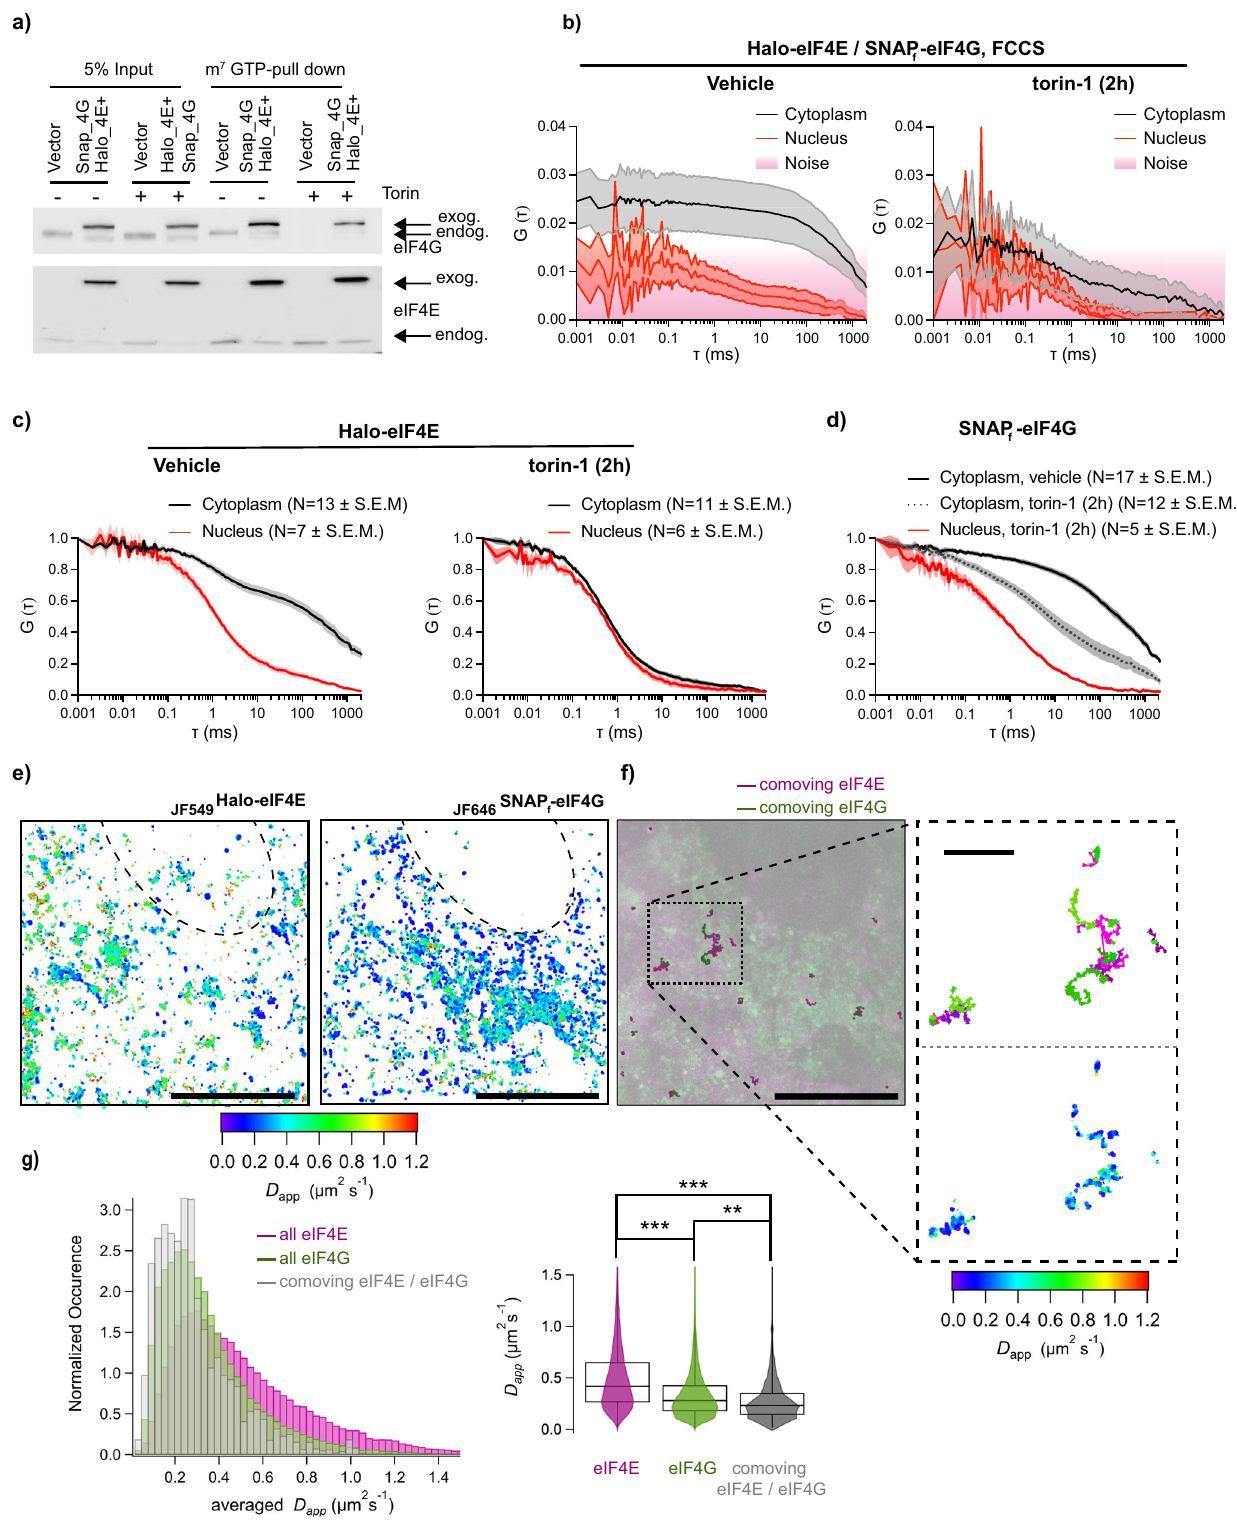
diffusion map and demonstrated that mRNA:Halo-eIF4E molecules were almost immobile. This demonstrated that the static translation factors likely represented translation initiation in neuronal